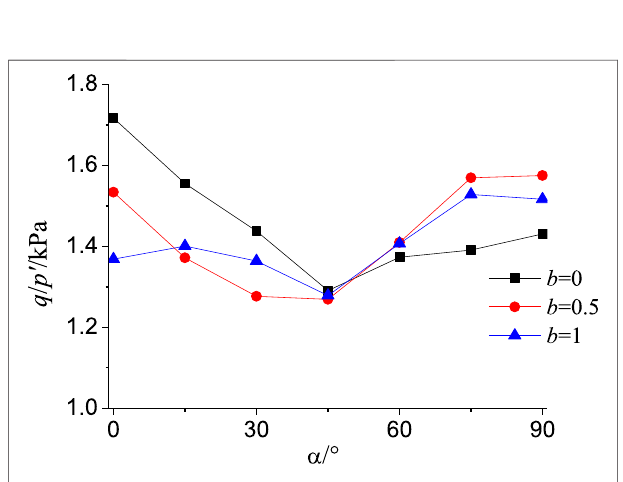
FIGURE 7 | Strength ratio under different inclinations of the principal stress direction angle